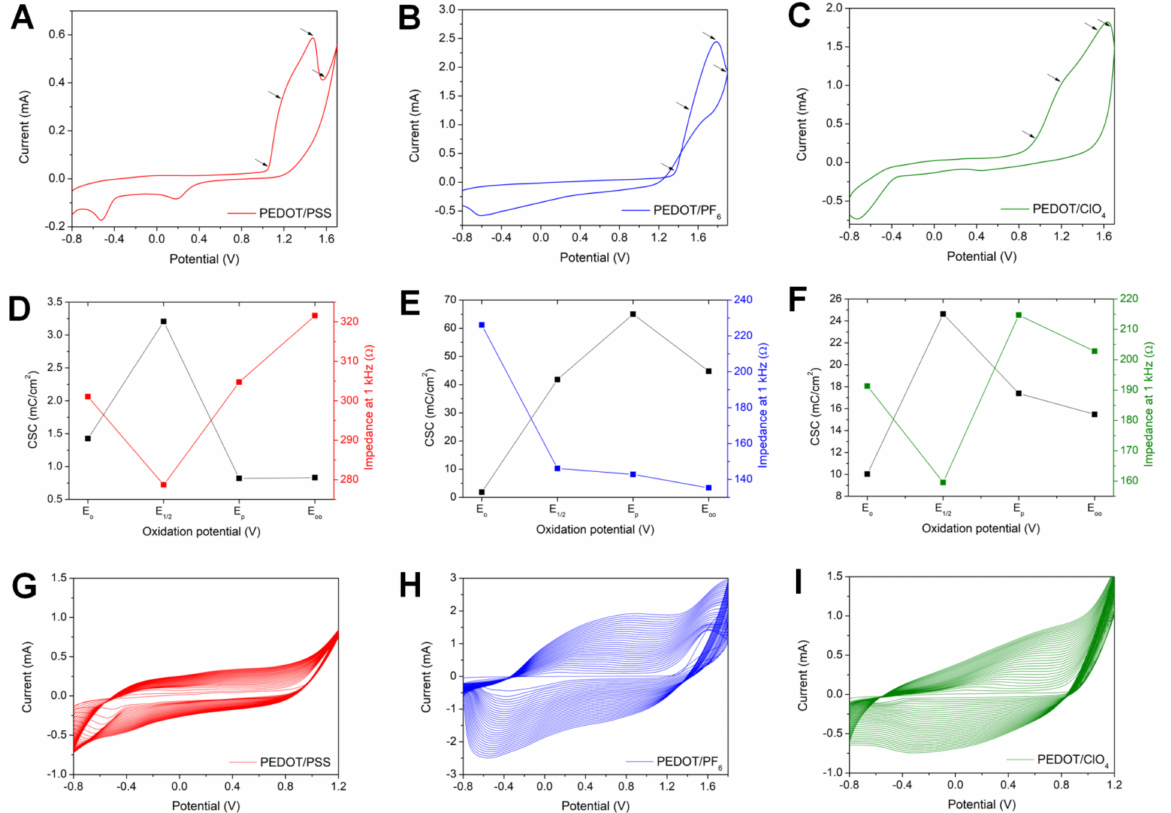
Figure 1. Optimization of electropolymerization conditions for each doping system (PEDOT/PSS, PEDOT/PF 6 , and PEDOT/ClO 4 ). ( A – C ) CV curves showing the selection of oxidative potentials based on the position of a polymerization peak, where E o is the onset potential, E 1/2 is the half-peak potential, E p is the peak potential, and E oo is the overoxidation potential. ( D – F ) The variation of charge storage capacity (CSC) and impedance modulus at 1 kHz with the choice of an oxidative potential. ( G – I ) CV curves showing the electropolymerization of EDOT under optimized